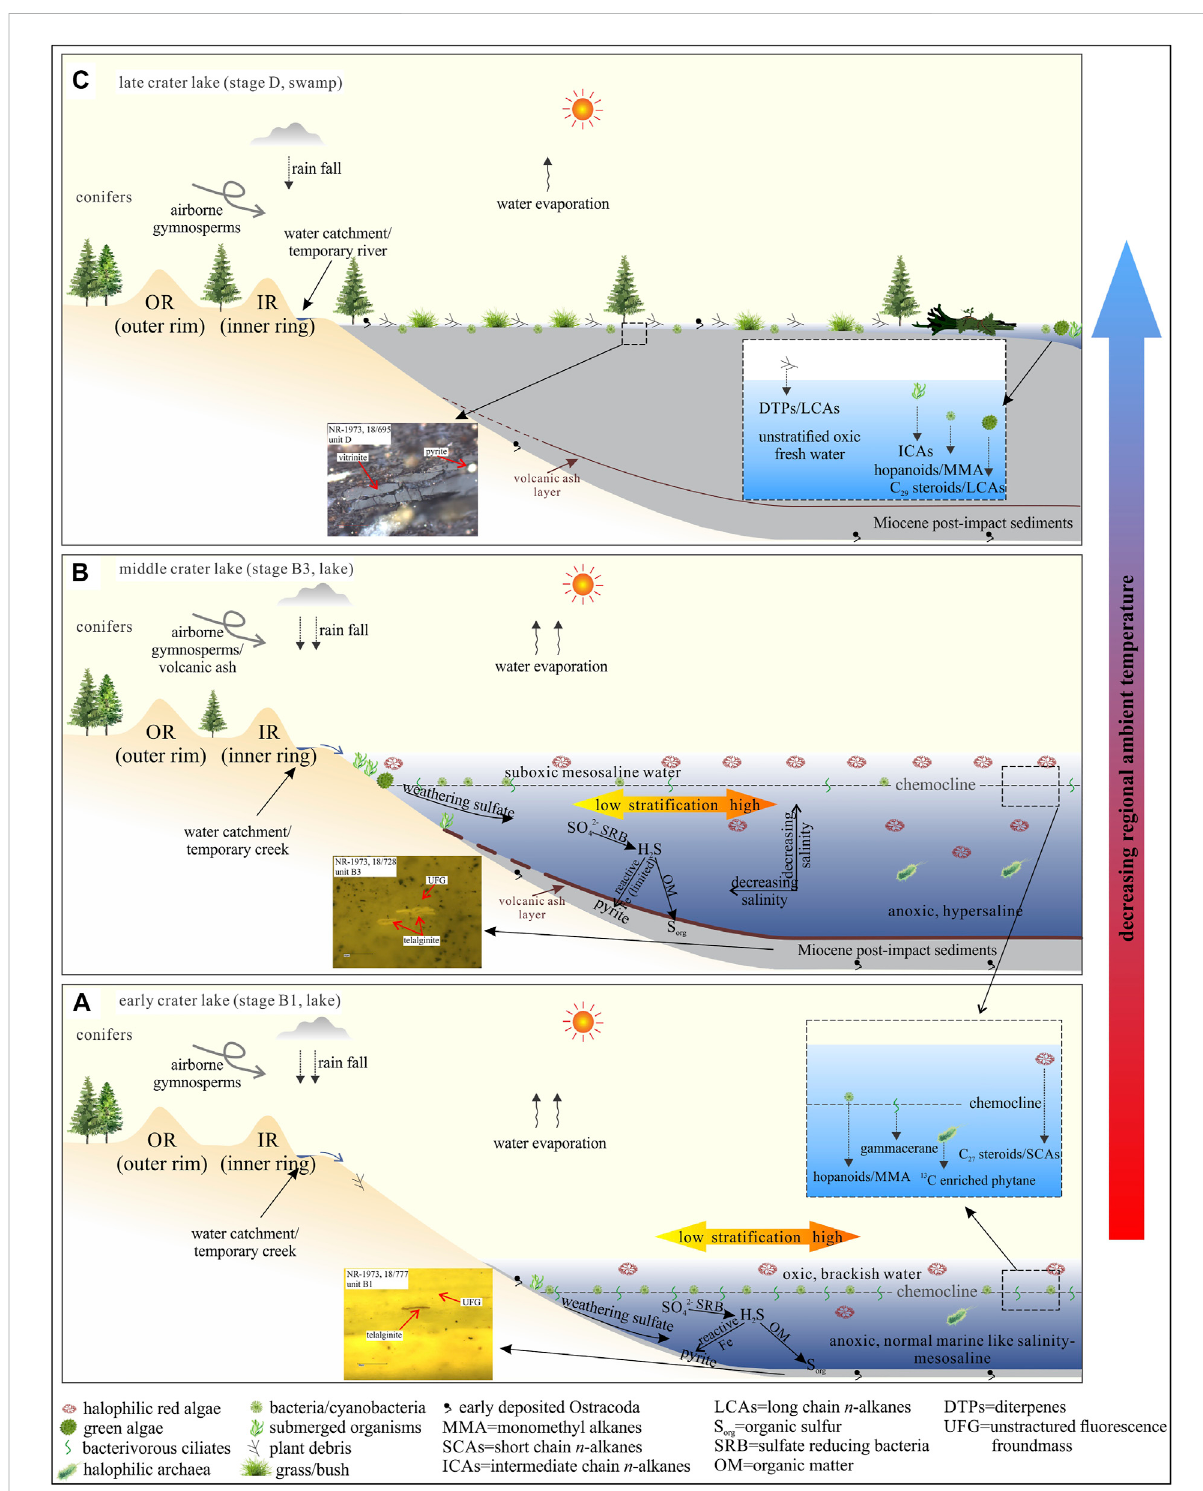
FIGURE 15 Evolutionary model of the paleo Nördlinger Ries lake. (A) Early crater lake, (B) middle crater lake, (C) late crater lake phase. Stages B1, B3 and D refer to stratigraphic units in Figure 2. OR=outer rim, IR=inner ring. Paleontology follows Arp et al.